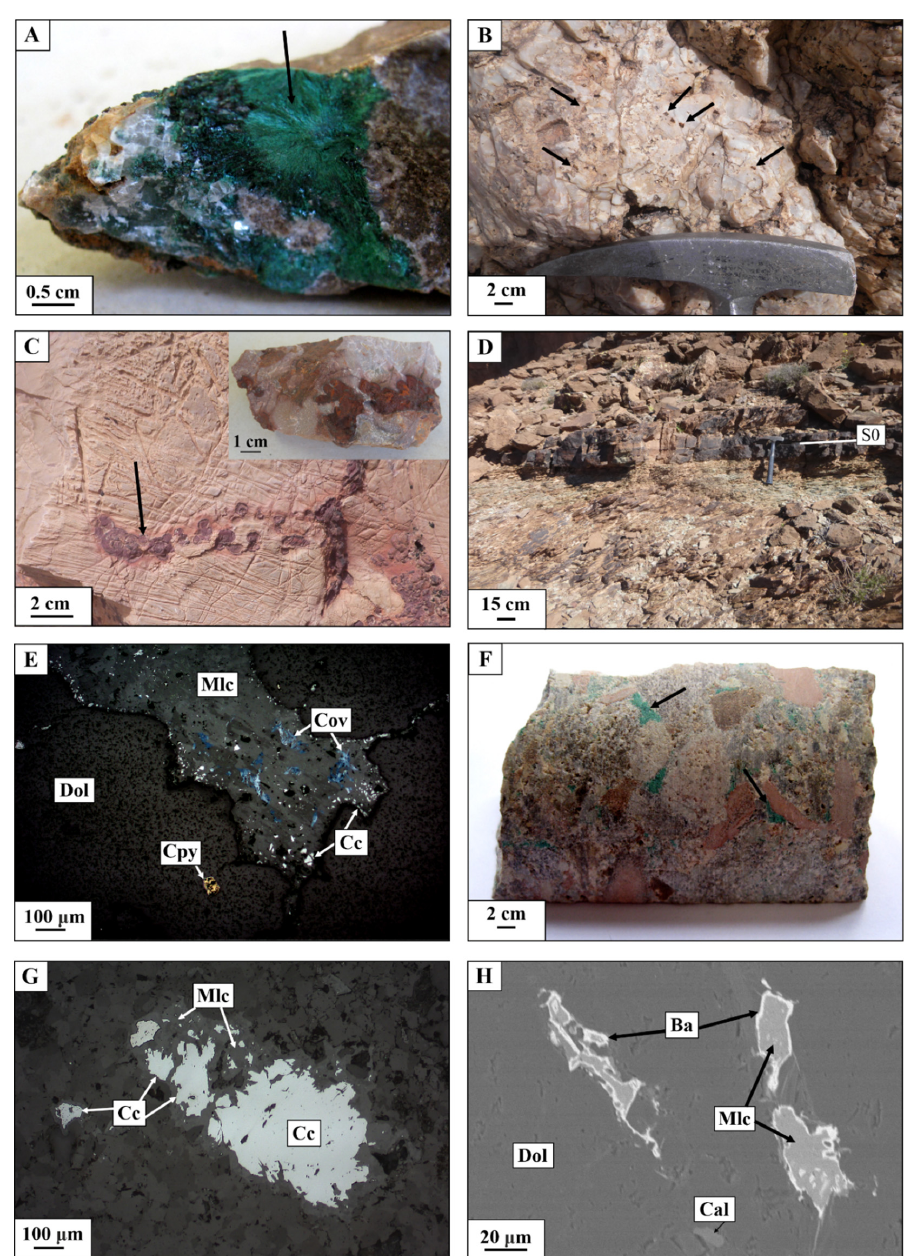
Figure 6. Images of typical weathered materials of the Tizert deposit: field and samples pictures ( a – d , f ) reflected polarized light microphotographs ( e , g ) and SEM microphotographs in the backscattered electrons mode ( h ). ( a ) Malachite (Mlc) and calcite (Cal) in the Tamjout Dolomite (TIZ 18); ( b ) Pyrite dissolution ghosts in quartz veins in the Tamjout Dolomite; ( c ) Hematite in the Tamjout Dolomite (TIZ 33); ( d ) Stratification plan (S0) in the Tamjout Dolomite; ( e ) Malachite, chicken-wire chalcocite (Cc), covellite (Cov) and chalcopyrite (Cpy) in the Tamjout Dolomite (Dol—dolomite, C15 C1); ( f ) Malachite in matrix of Basal Conglomerate (C15 C5); ( g ) Malachite and chalcocite in greyish red sandstone in Basal Series (C1 12); ( h ) Malachite surrounded by barite (Ba) in greyish red sandstone from Basal Series (C1 12).